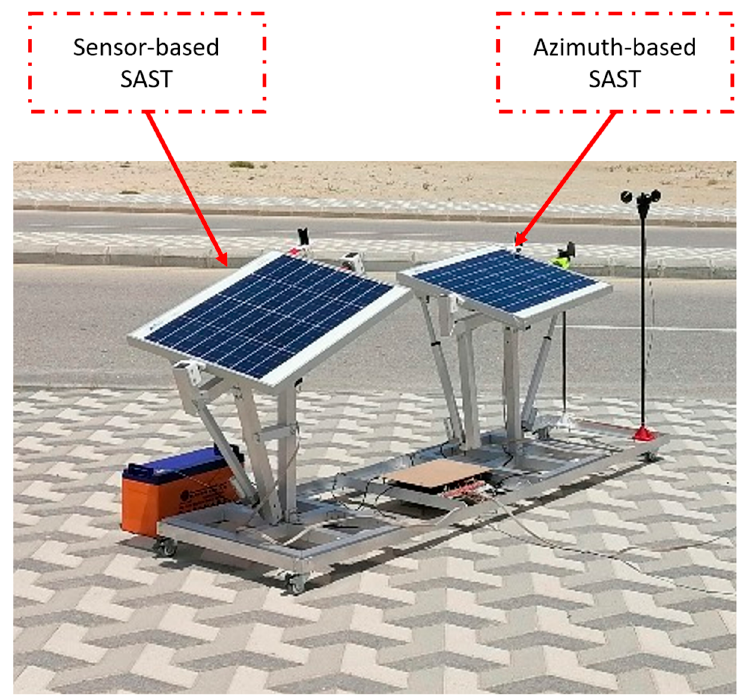
Figure 8. Test setup of consist of sensor-based SAST and azimuth-based SAST. Table 2. Cost of the